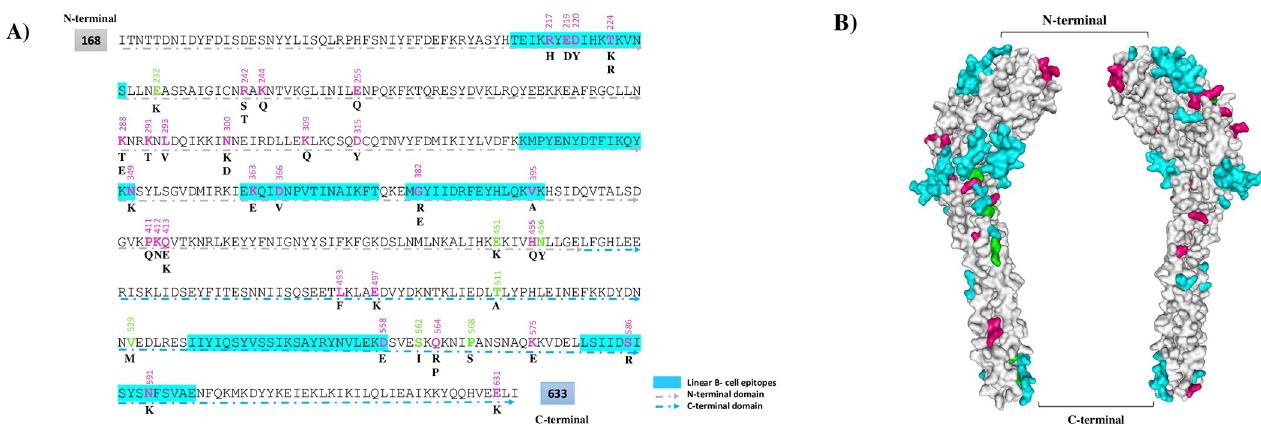
Fig 4. A) Amino acid sequence of PvRBP2b (Sal-I sequence, PVX_094255). The SNPs positions are specified in bold format and pink (detected SNPs in Iranian and worldwide populations), green color (detected SNPs in worldwide except Iran), and blue boxes show the predicted linear B-cell epitopes. The grey and blue arrows represent N- and C-terminal regions, respectively. B) The predicted conformational B-cell epitopes are mapped on 3D-structure of PvRBP2b (PDB code: 6d03) by using WebLab Viewer Lite 4.2. The color of the detected SNPs in Iranian population is shown in pink and detected SNPs in worldwide except Iran is green. In addition, the predicted conformational B-cell epitopes are in blue and white represents backbone amino